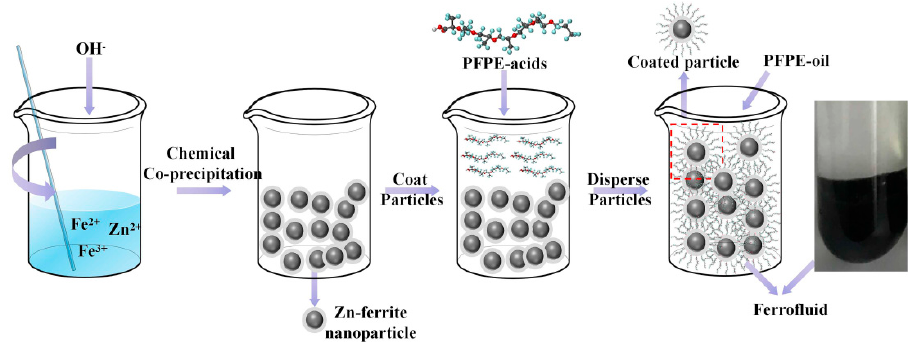
Figure 1. Schematic illustration of the preparation process for Zn-ferrite nanoparticles and PFPE oil- based